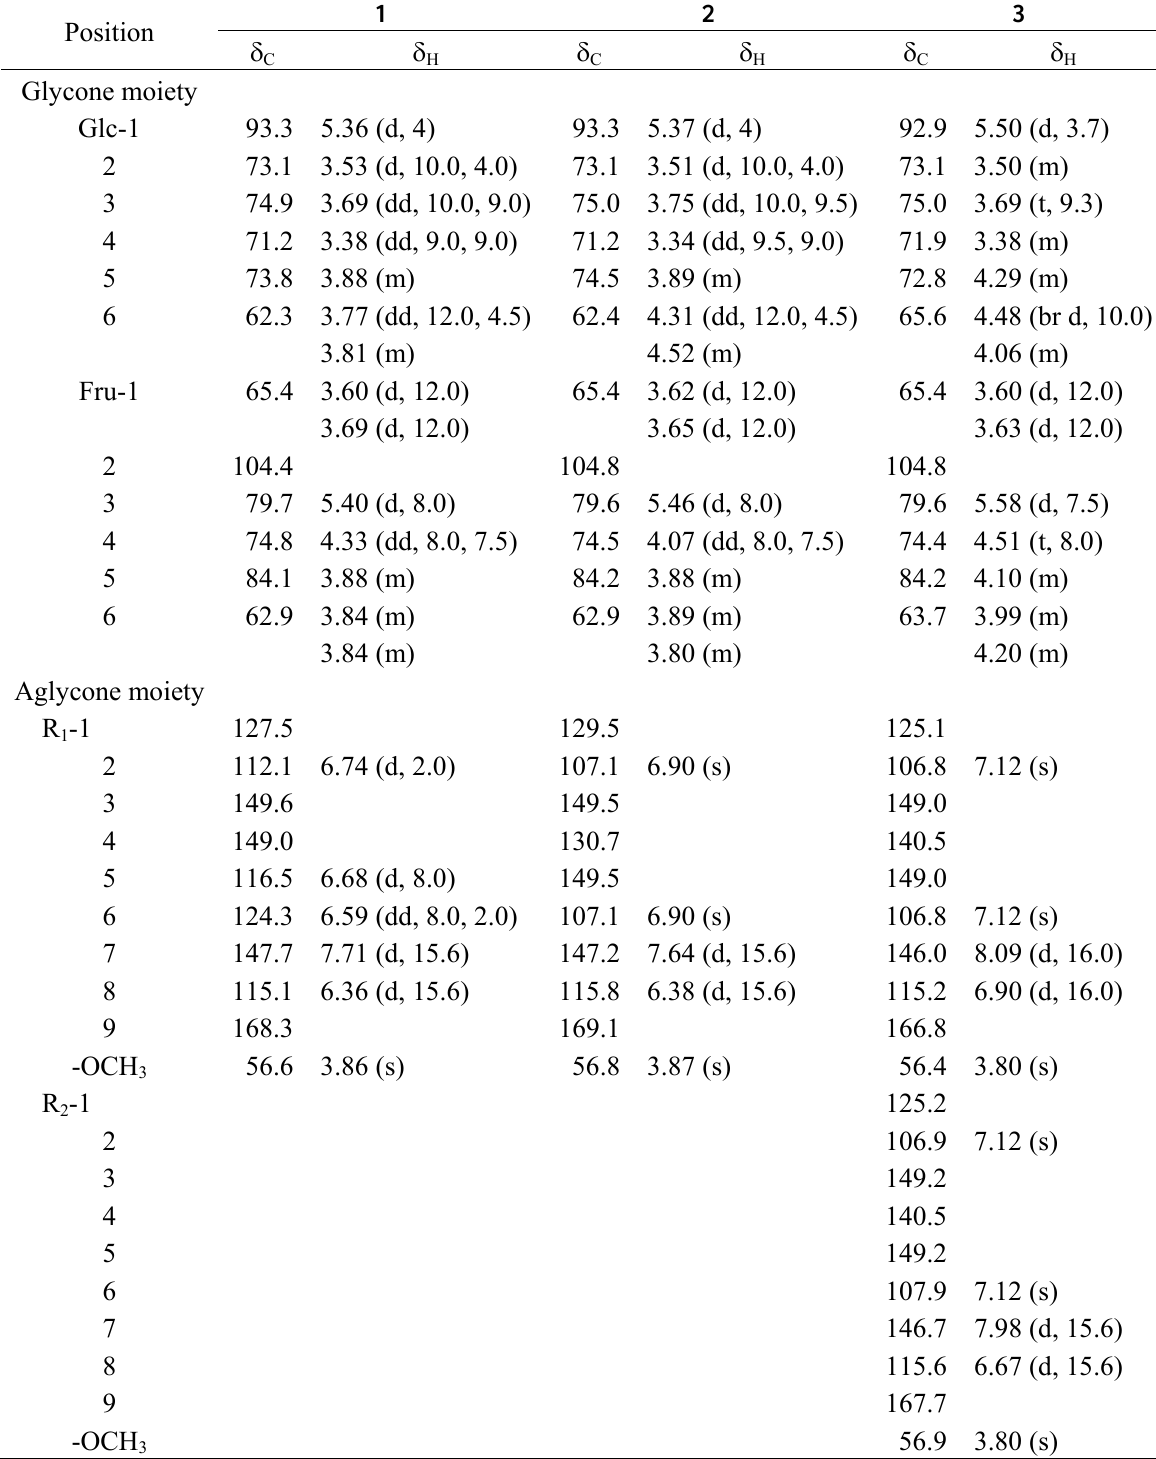
Table 1. 1 H-NMR (500 and 400 MHZ) and 13 C-NMR (125 and 100 MHz) data of compounds 1 - 3 in CDCl ( δ in ppm, J in 3